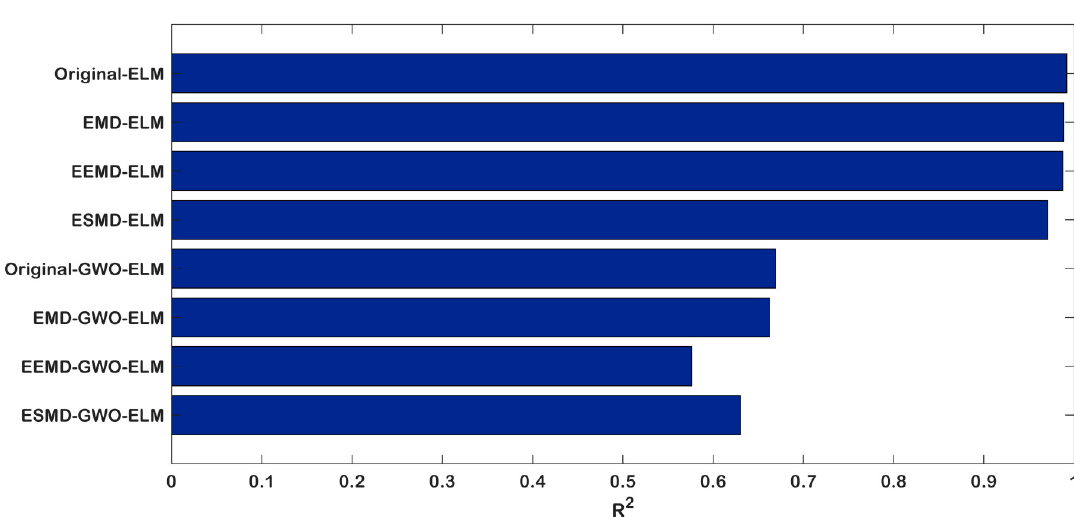
Figure 13. The values of the MAPE parallel models.